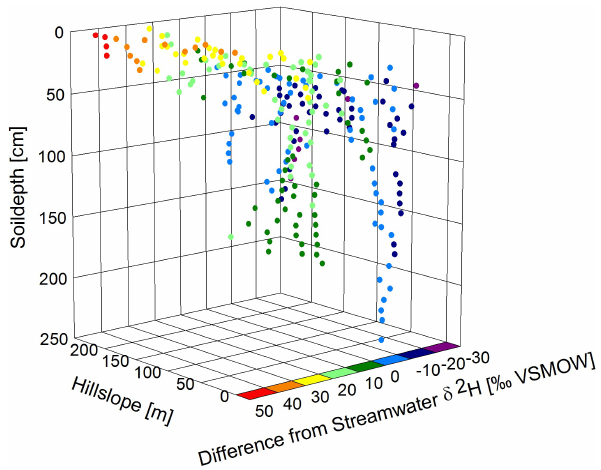
Fig. 9. Difference from streamwater δ 2 H as a function of soil depth and distance to the stream for all samples along both study hillslope transects ( n = 248).